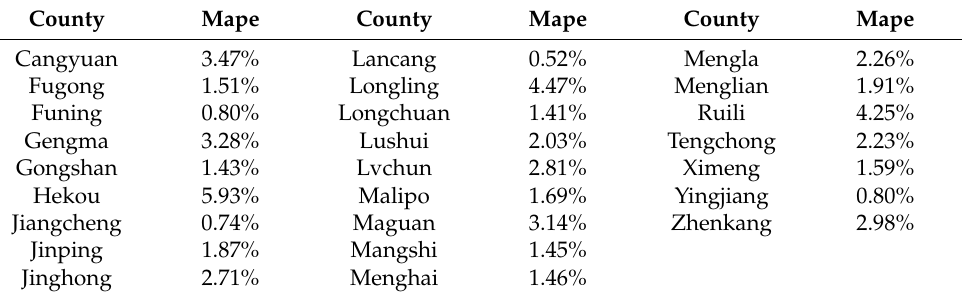
Table 4. Mean absolute percent error (MAPE) for each county, which was used to test the accuracy of the model; a MAPE > 10% indicates that the predicted results are highly